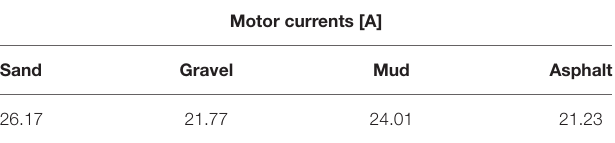
TABLE 2 | Equivalent track values for different terrains.